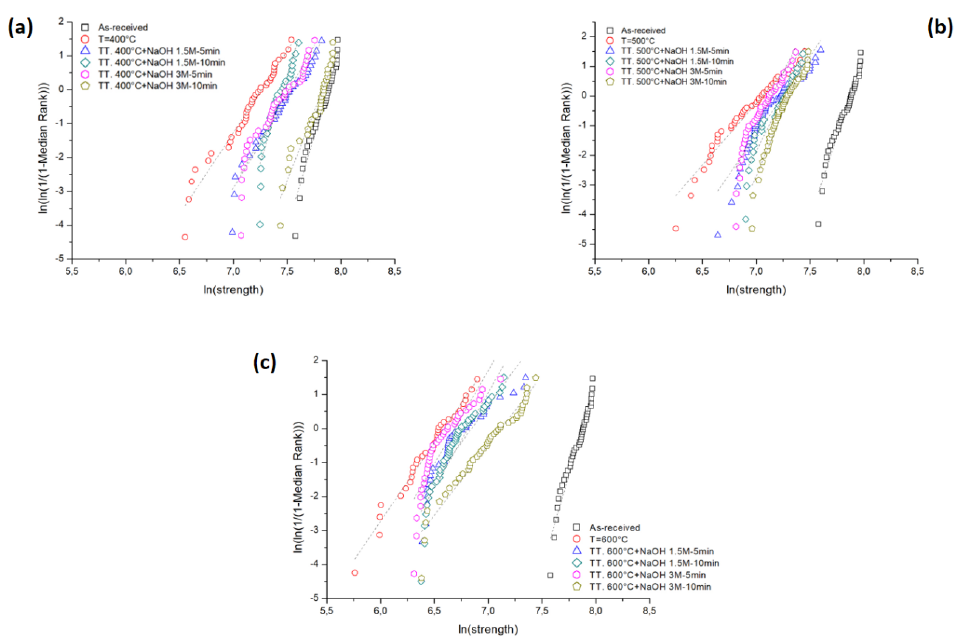
Figure 4. Weibull plots for the tensile strength of basalt fibres after NaOH treatment as a function of thermal treatment temperature: ( a ) 400 °C, ( b ) 500 °C, ( c ) 600 °C.